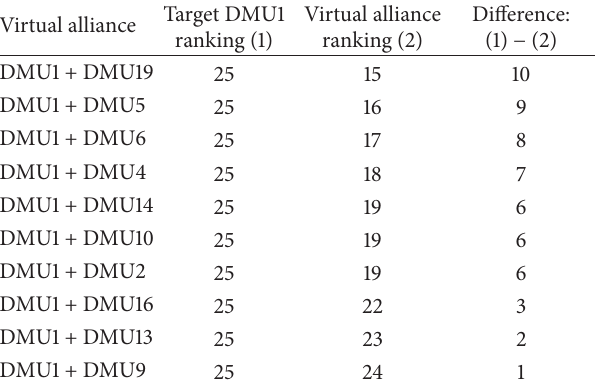
Table 13: The good alliance partnership.